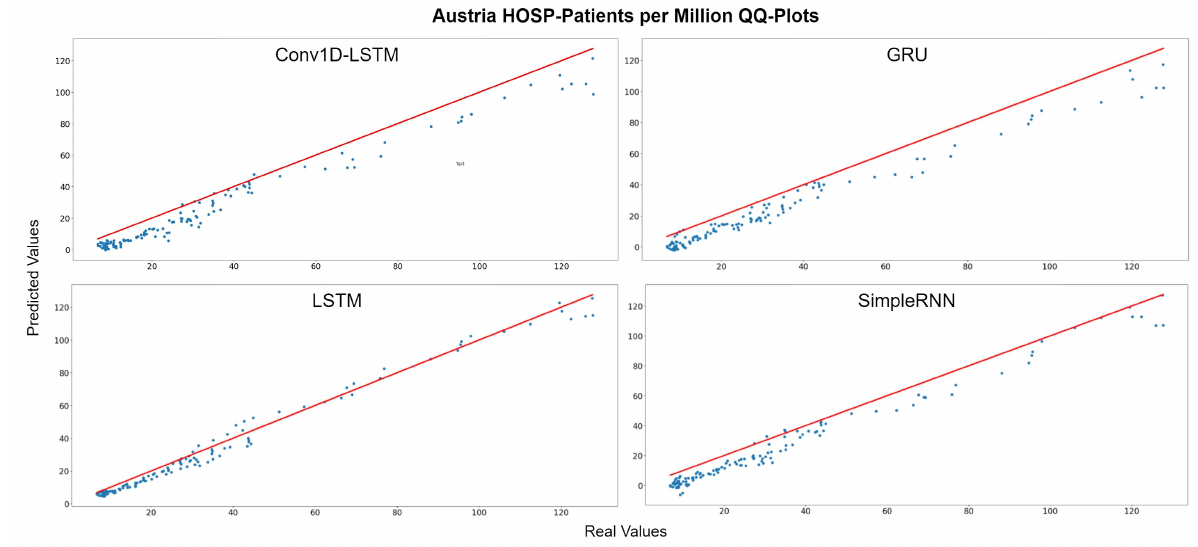
Figure 17. Austria HOSP-Patients per million QQ-Plot for each